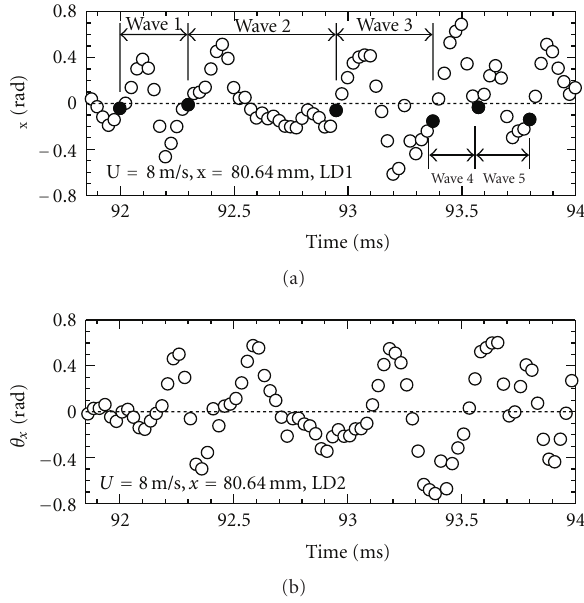
Figure 6: Typical slope angle data and crossings detected by zero- upcrossing